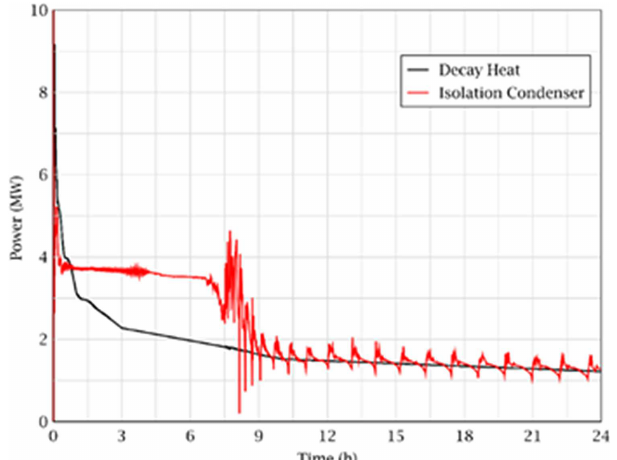
Fig. 4. Power removal by IC in a PWR configuration (effect of the N 2